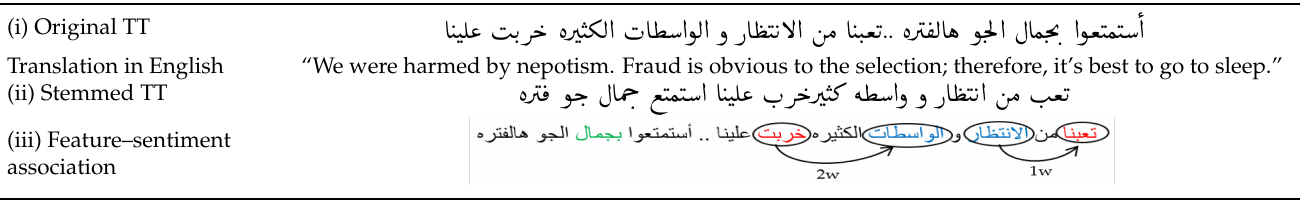
Table 4. Sentiments in